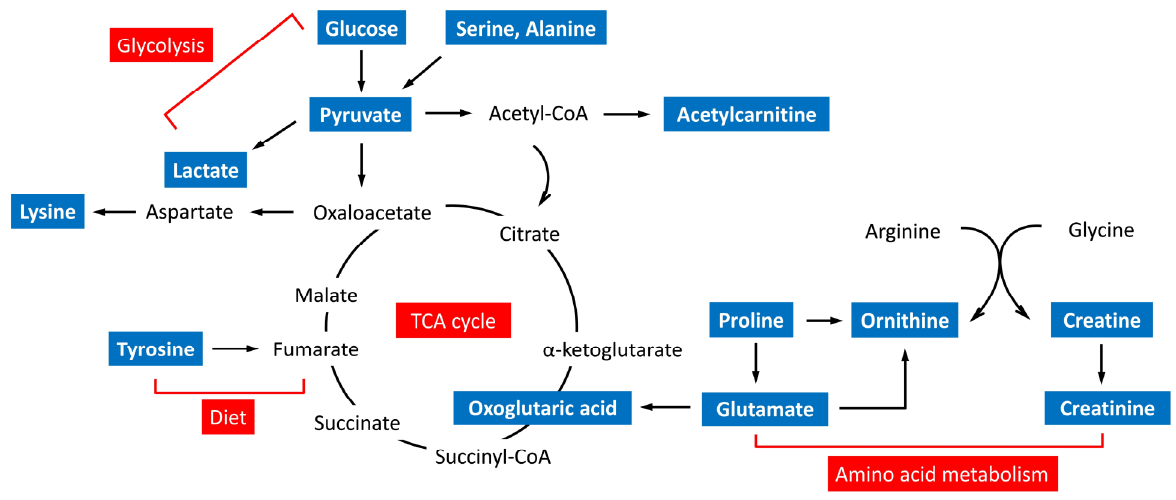
Figure 2. Schematic overview of the metabolic pathways associated with cholesterol-related metabo- lites.